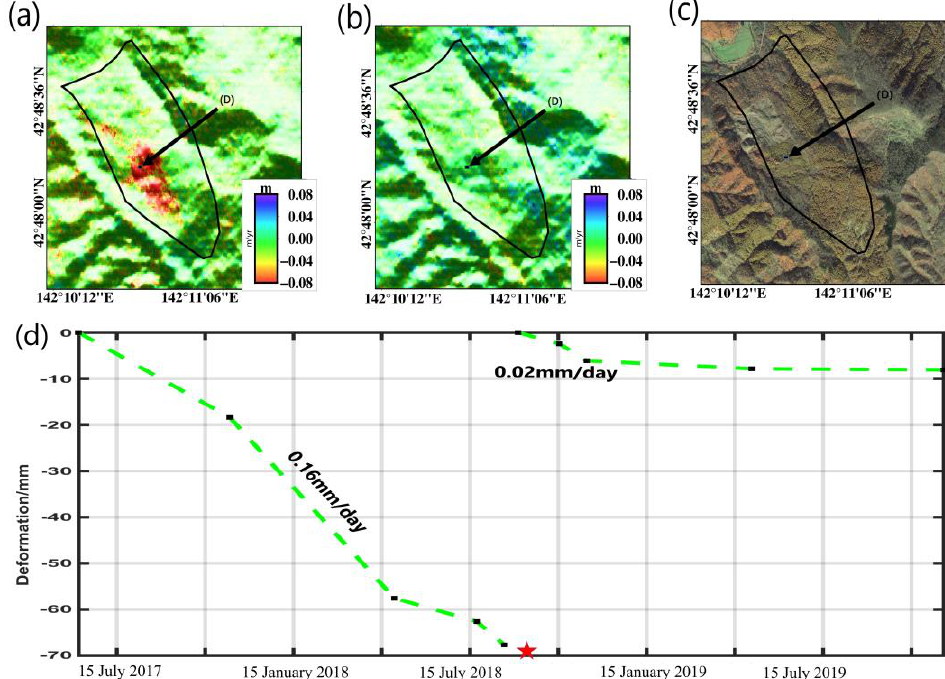
Figure 12. ( a , b ) Average LOS deformation velocities of landslide B1 before and after the earthquake, respectively. ( c ) Optical image of landslide B1. ( d ) Time series deformation of point D before and after the earthquake. The pentagram indicates the time of the earthquake.